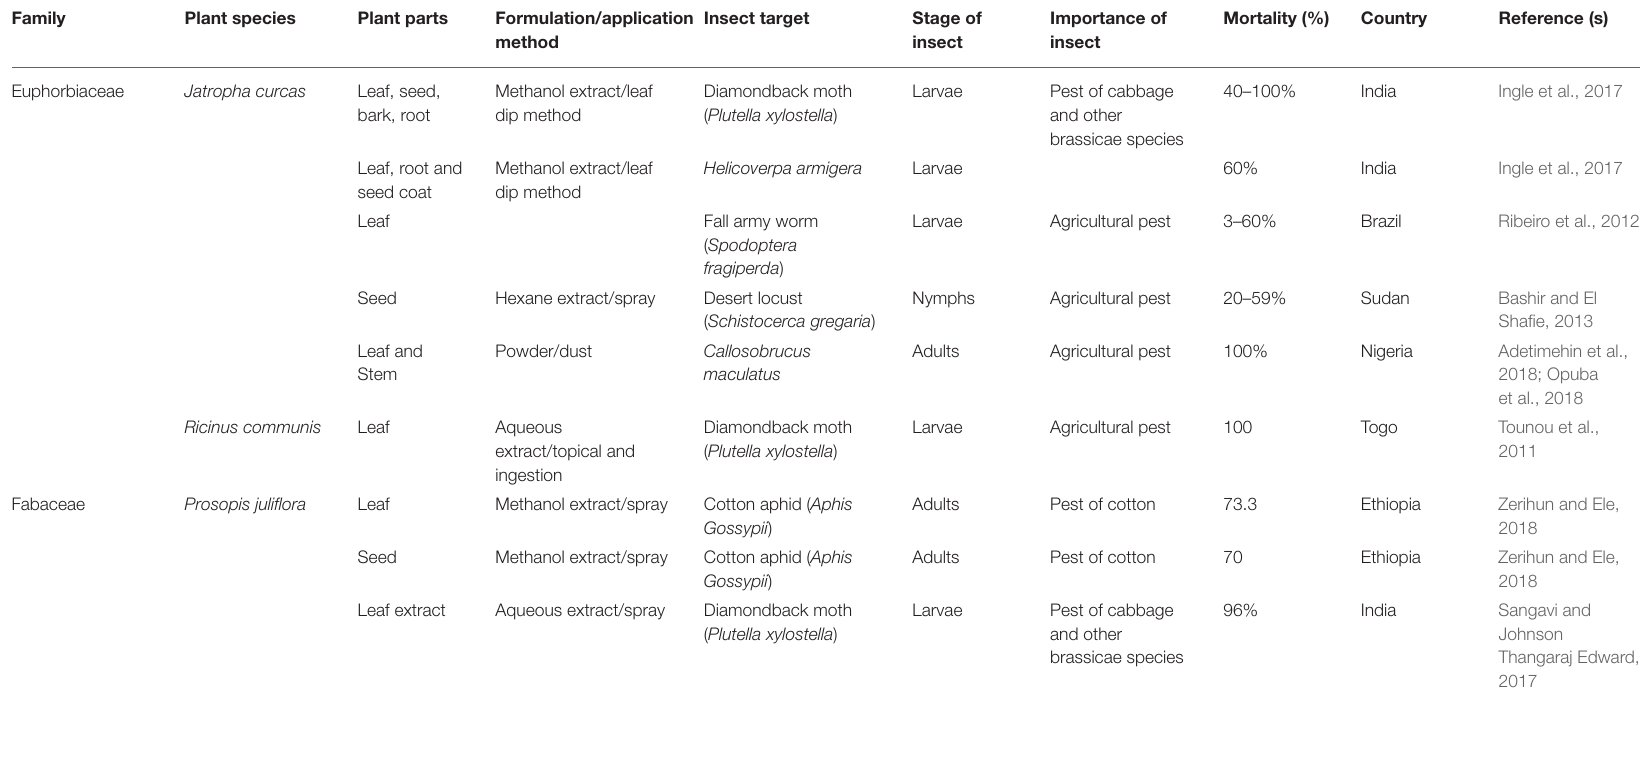
TABLE 2E | Published reports on the insecticidal activities of some plant species with invasive potentials in sub-Saharan